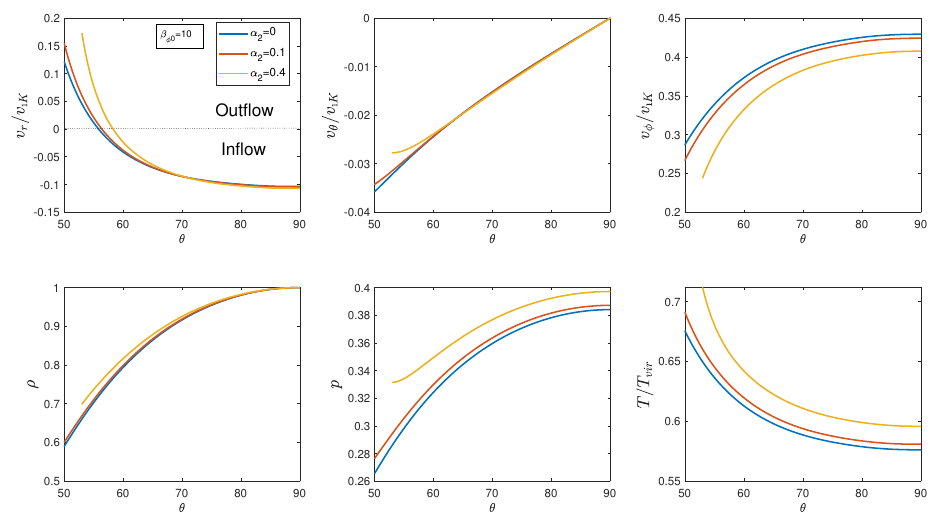
Figure 5. Angular profiles of velocities ( v r , v θ , v φ / v k ), density ( ρ ), pressure ( p ), and temperature ( T / T vir ). The blue, red, yellow lines correspond to parameters α 2 = 0.0,0.1,0.4, respectively. In this model, we set the gas pressure is 10 times larger than the magnetic pressure at the midplane.